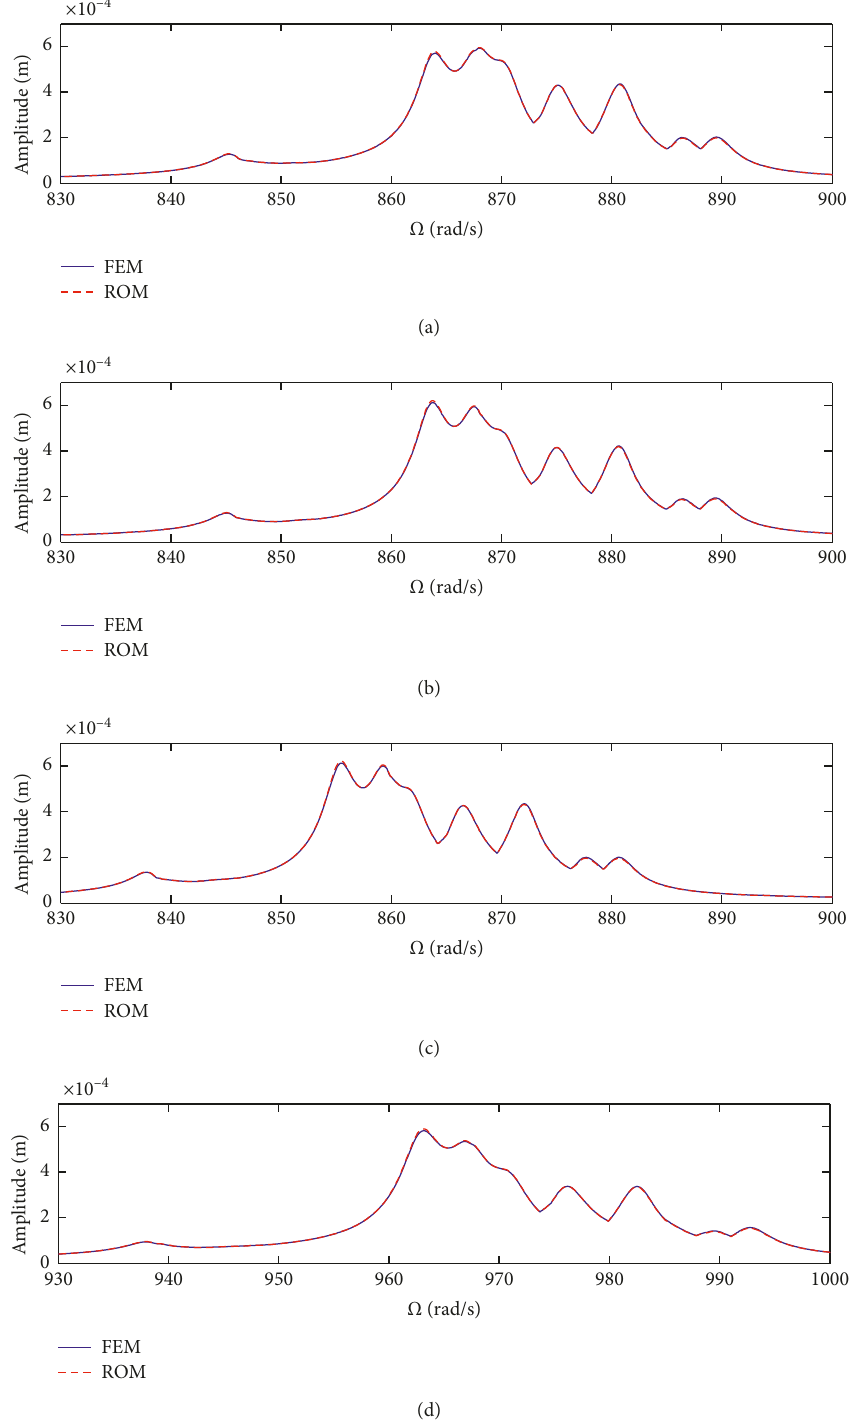
Figure 4: Comparison on the forced response versus rotating speed between the full-order model and ROM excited by a 4EO backward traveling wave excitation: (a) case STA, (b) case COR, (c) case SOF, and (d) case